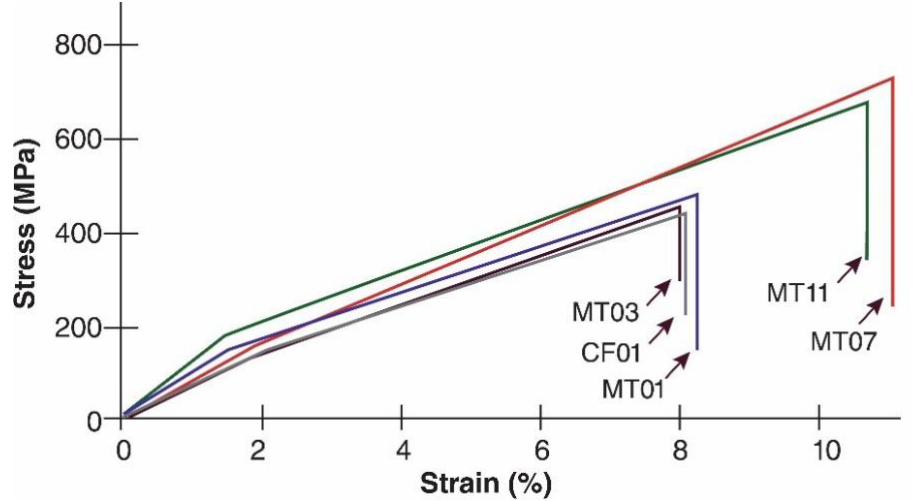
Figure 2. Fiber tension test for five genotypes of M. textilis .